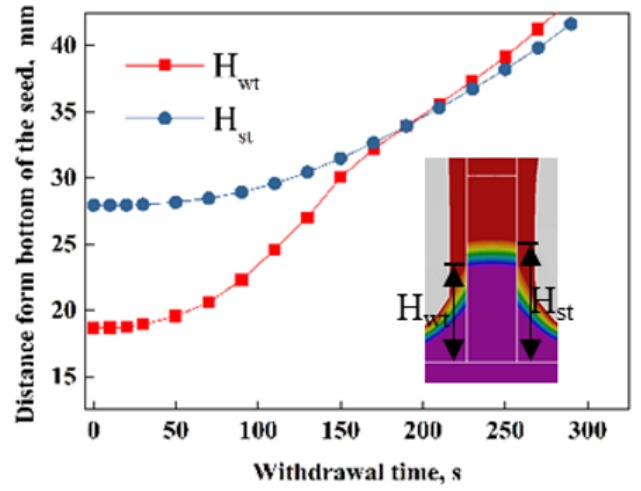
Figure 5. The variation in liquidus temperature point with withdrawal time. Hwt refers to the dis ‐ tance between the liquidus temperature point on the inner surface of the mold and the bottom of the seed, while Hst refers to the distance between the liquidus temperature point at the edge of the seed and the bottom of the seed.